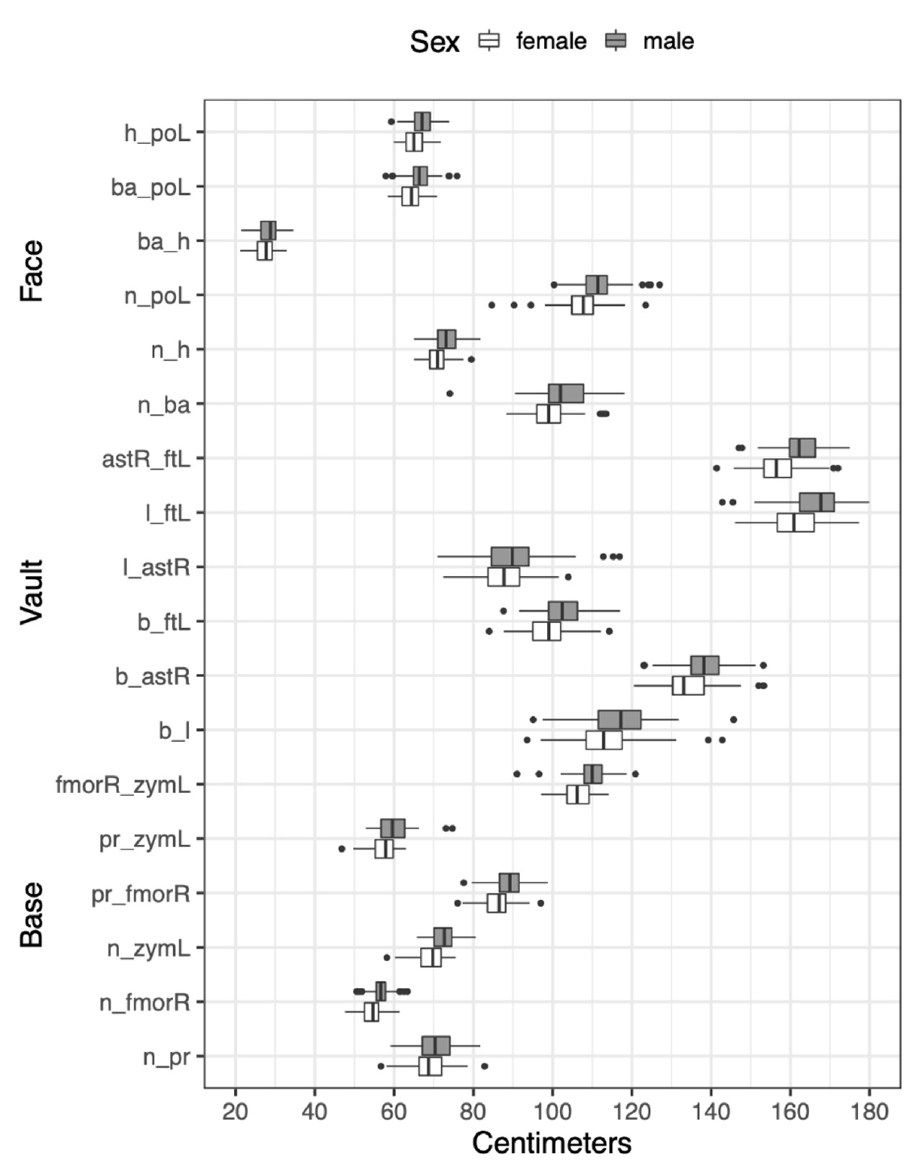
Figure 1. Distributions of raw cranial data for males and females. Cranial landmark abbreviations are defined in Table 2.